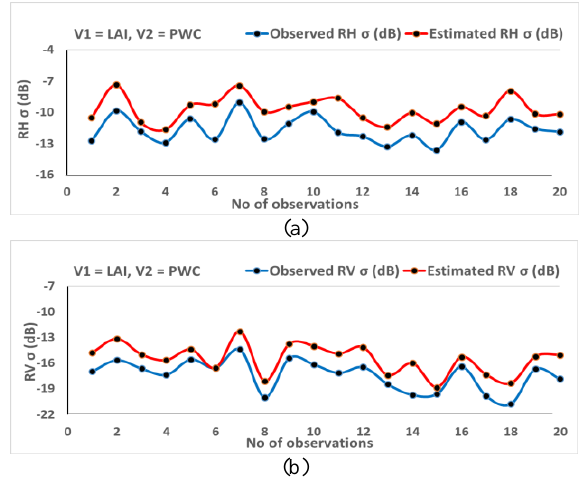
Figure 4. Observed v/s Estimated (a) RH and (b) RV